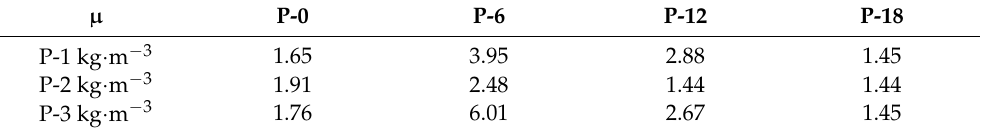
Figure 25. Isoenergetic method to find the yield strength.